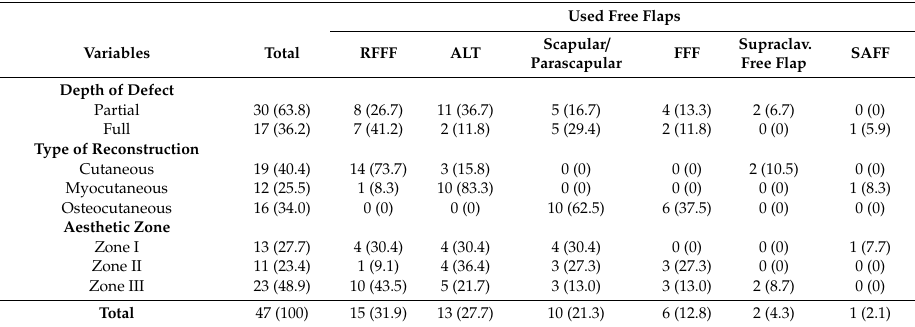
Table 2. Free flap